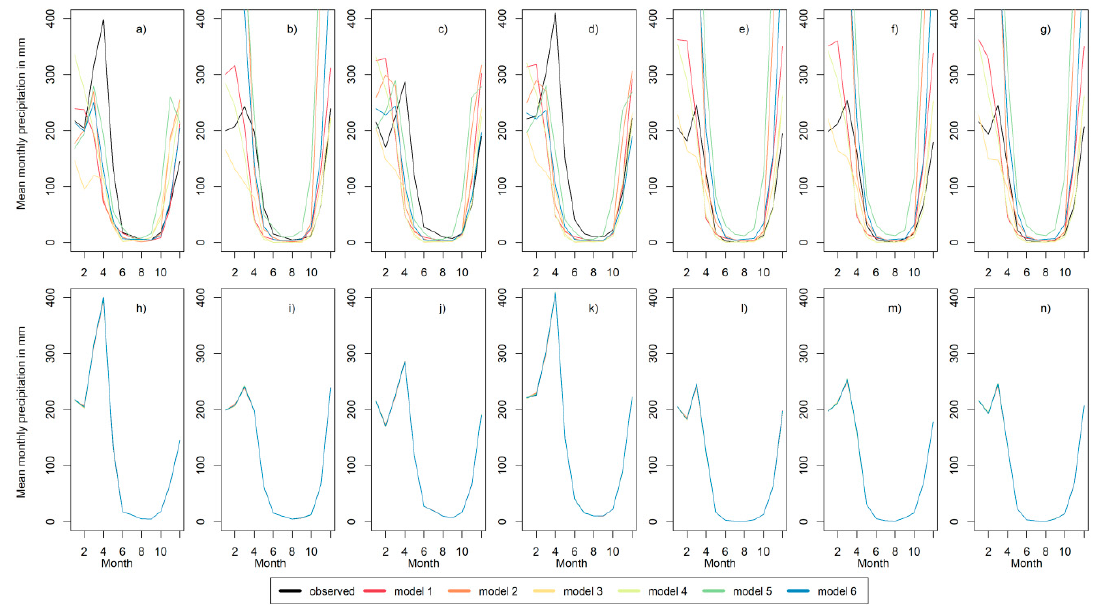
Figure 5. Average monthly precipitation from 1951–2005 for the seven datagrids of CORDEX Africa before bias-correction in ( a – g ) and for the same stations after bias correction in ( h – n ). The lines representing the precipitation for the observed precipitation, as well as for models 1 to 5, are superimposed by the lines for model 6 due to their similar precipitation after bias correction (h–n). Each graph shows the average monthly precipitation for all six models introduced in Table 2.